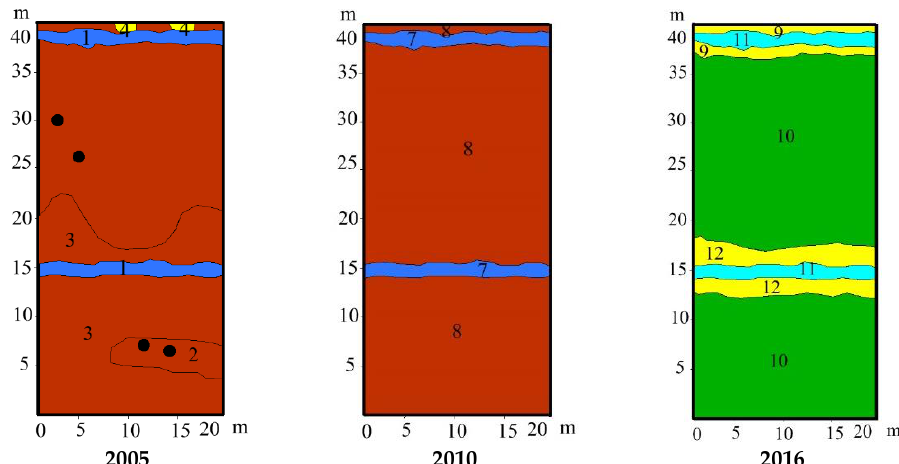
Figure 15. Changes in vegetation on permanent plot No. 11: 1 single Vaccinium uliginosum ,